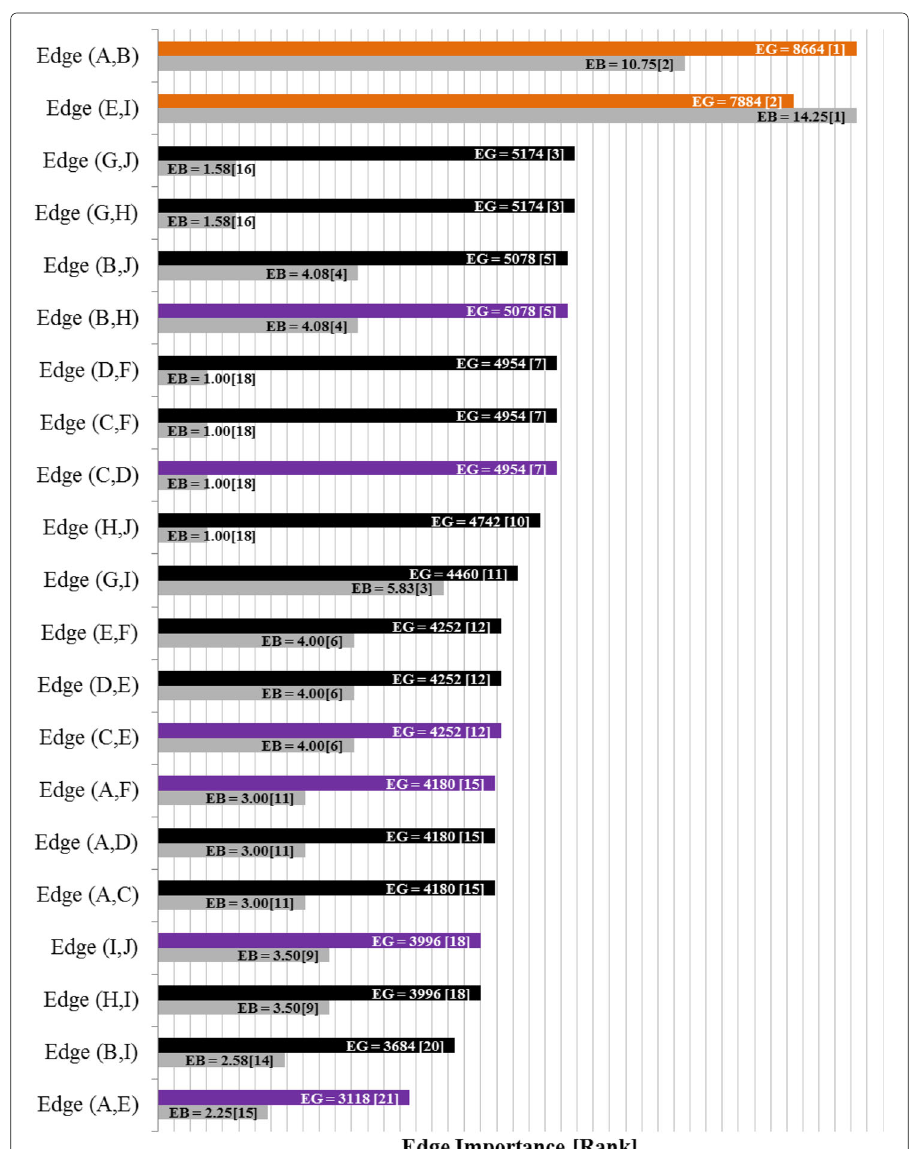
Fig. 9 Edge Gravity (EG) and Edge Betweenness (EB) solutions for Granovetter’s Example A